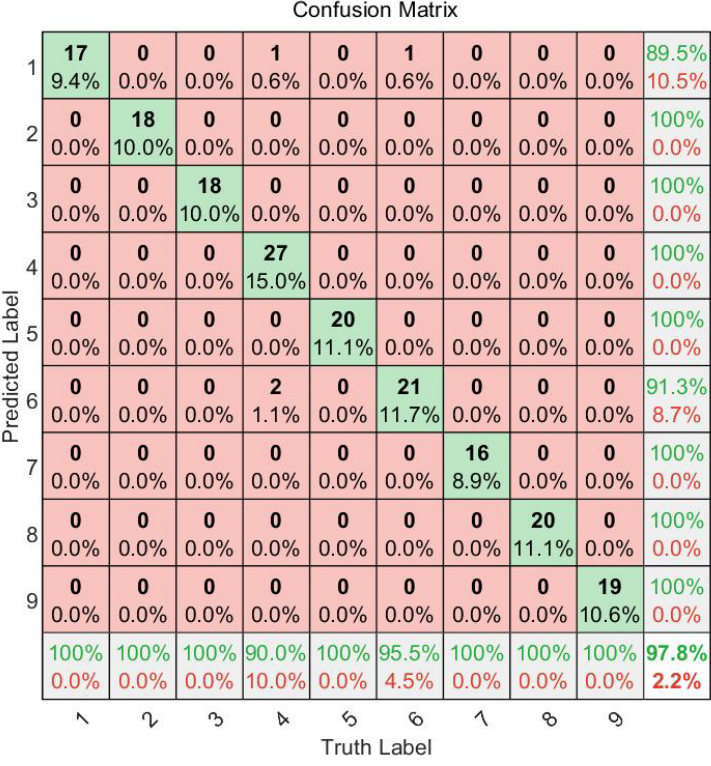
Figure 15. CNN model classification prediction results.